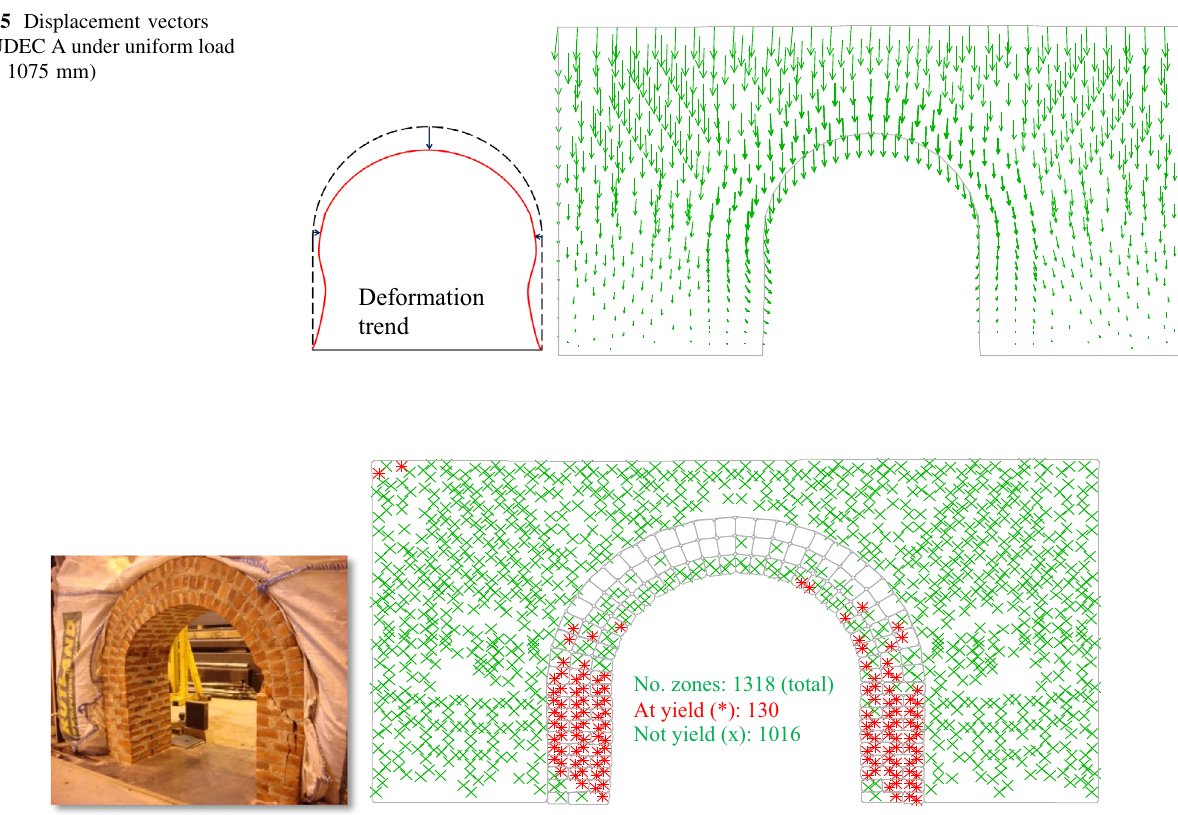
Fig. 6 Failure state of UDEC A compared with experimental test 1 under uniform load ( H = 1075